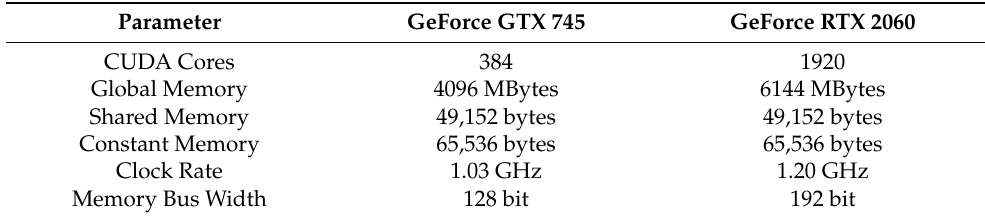
Table 1. Hardware parameters of the NVIDIA GeforceGTX745 and the NVIDIA